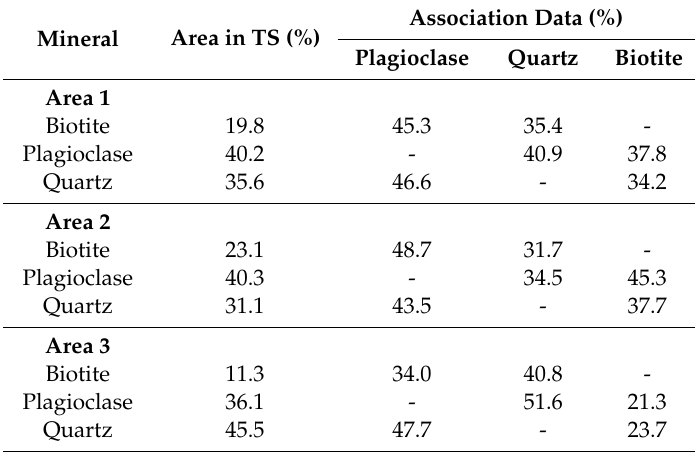
Table 4. Area% and association data for biotite, quartz and plagioclase in the three areas indicated in Figure 12C. TS = thin section. Association Data (%) Mineral Area in TS (%) Plagioclase